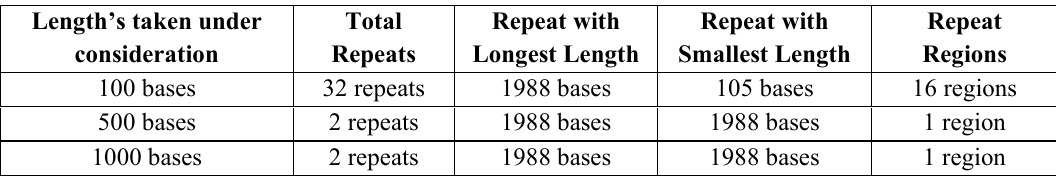
Table 4. S. cerevisiae (Brewer's Yeast) Eighth Chromosome’s Repeats Having 100% Similarity